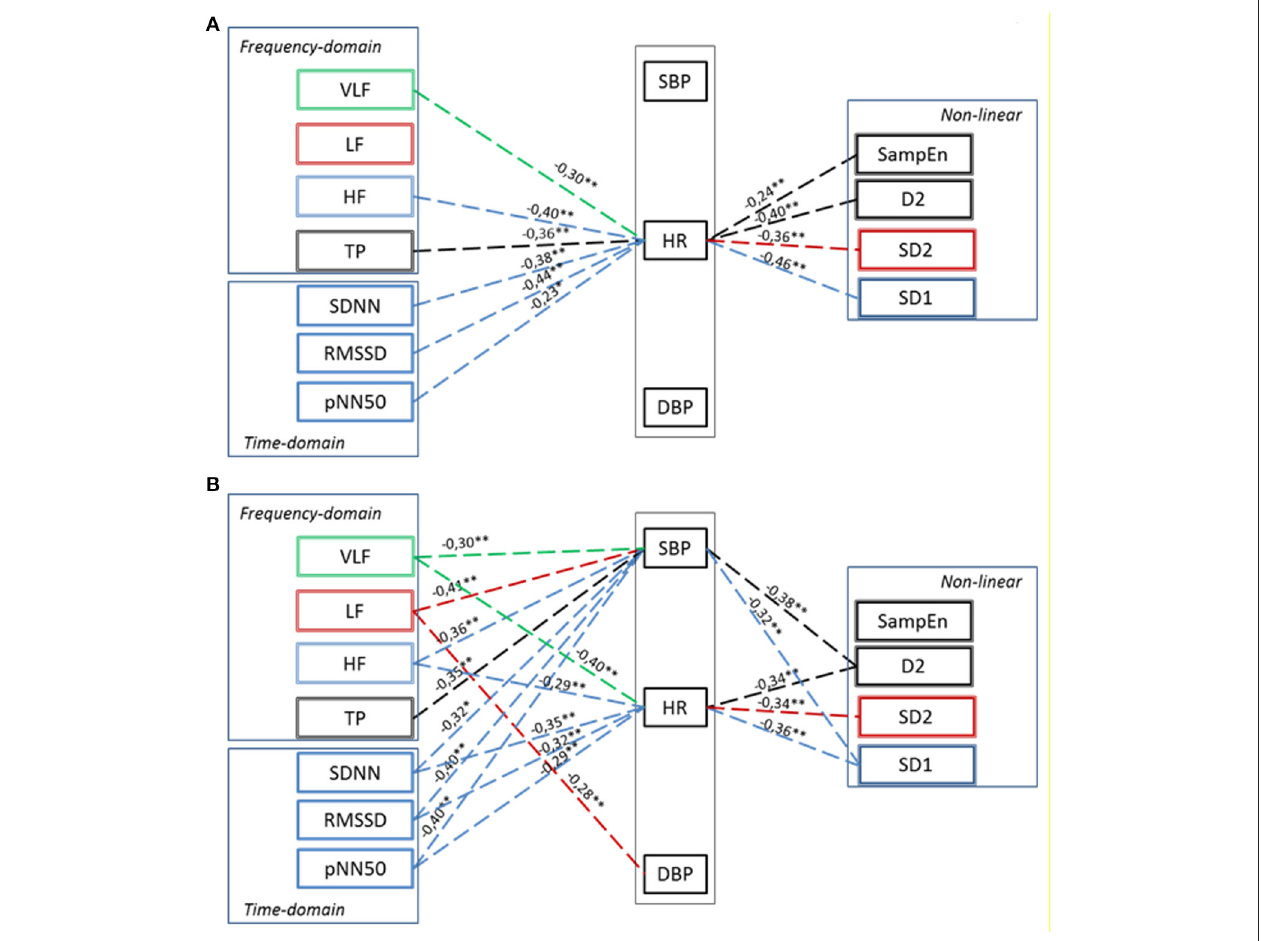
FIGURE 5 | Correlation between Hemodynamics and HRV parameters in PD patients in baseline conditions (A) and at 40th minute of “dry” immersion session (B) . HR, heart rate; SBP, systolic blood pressure; DBP, diastolic blood pressure. Dashed line—the negative correlation. Significance of Spearman correlation coefficient: * p < 0.05, ** p <